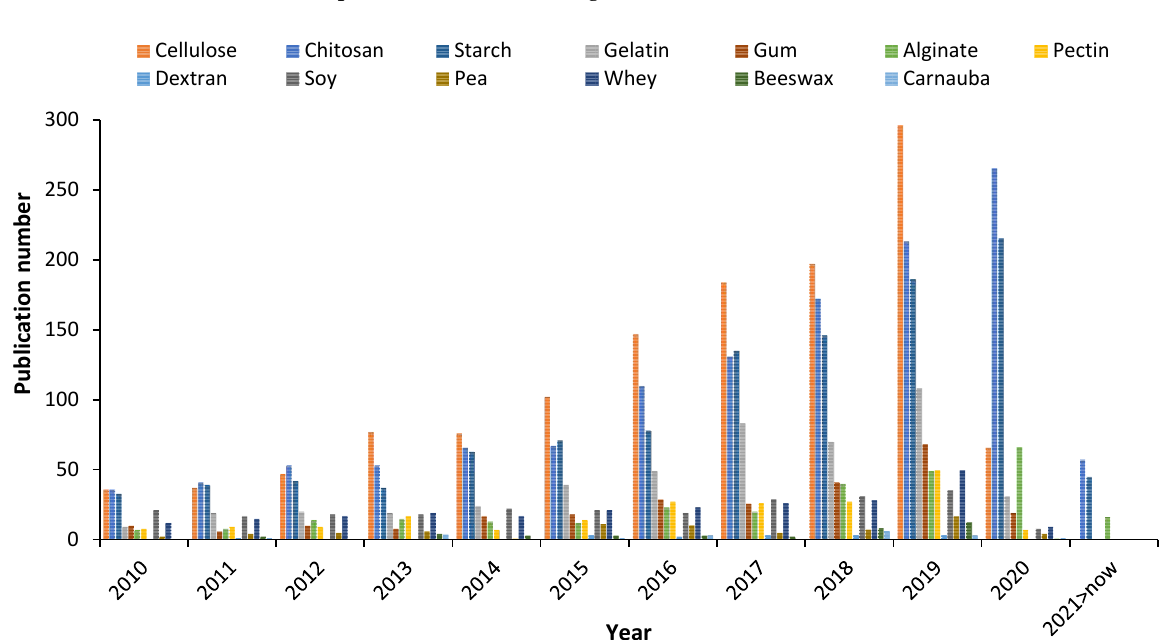
Figure 1. Publication number related to the fabrication of food packaging based on biopolymers (source Scopus, keywords: cellulose, chitosan, starch, gelatin, gum, alginate, pectin, dextran, soy, pea, whey, beeswax, and carnauba. Accessed: 22 February 2021).